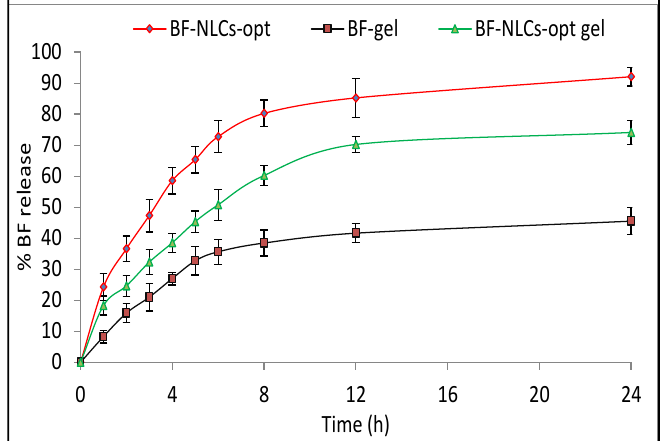
Figure 7. In vitro release study profile of BF-NLCopt, BF-NLCopt gel, and BF-gel. Each study was performed in triplicate and data are shown as mean ± SD. Comparison of permeation study of BF gel with BF-NLCsopt gel and BF-NLCs-opt. The significant differences observed at p < 0.001.